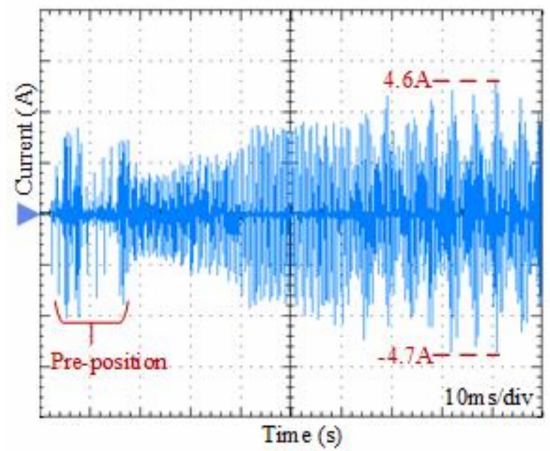
Figure 12. Measured CM current of 200 m